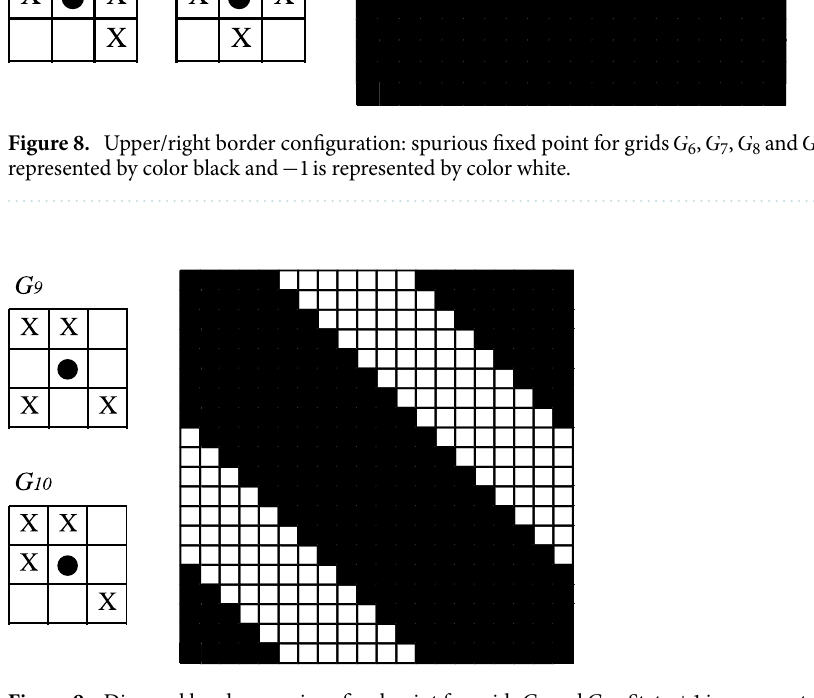
Figure 9. Diagonal border: spurious fixed point for grids G 9 and G 10 . State + 1 is represented by color black and − 1 is represented by color